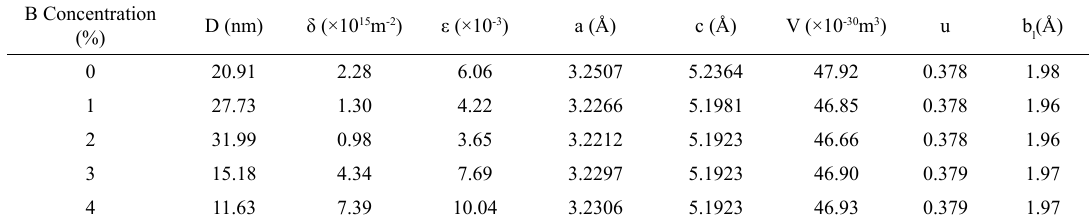
) of B-N codoped ZnO thin films with various B concentrations. l